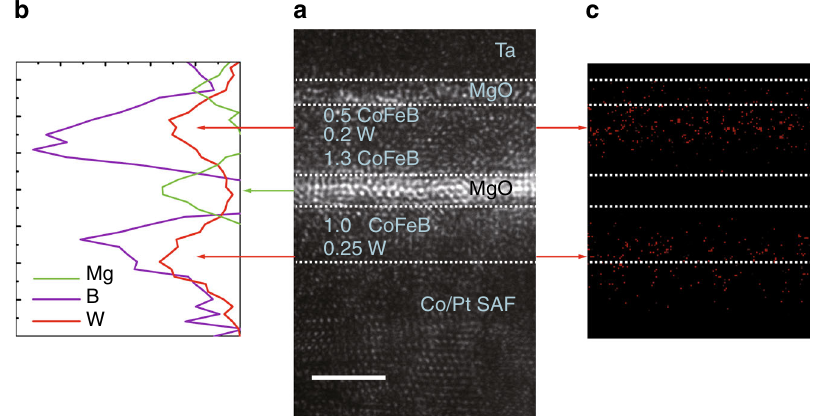
Fig. 5 Cs-corrected TEM and EELS results. a Cs-corrected TEM image that pro fi les the crystallization. The p-MTJ stack was annealed at 390 °C. The scale bar indicates 2 nm. b EELS intensities of Mg, B, and W. Arrows show the positions of the same layer in the two fi gures. c EDS mapping of the p-MTJ stack, where W is in